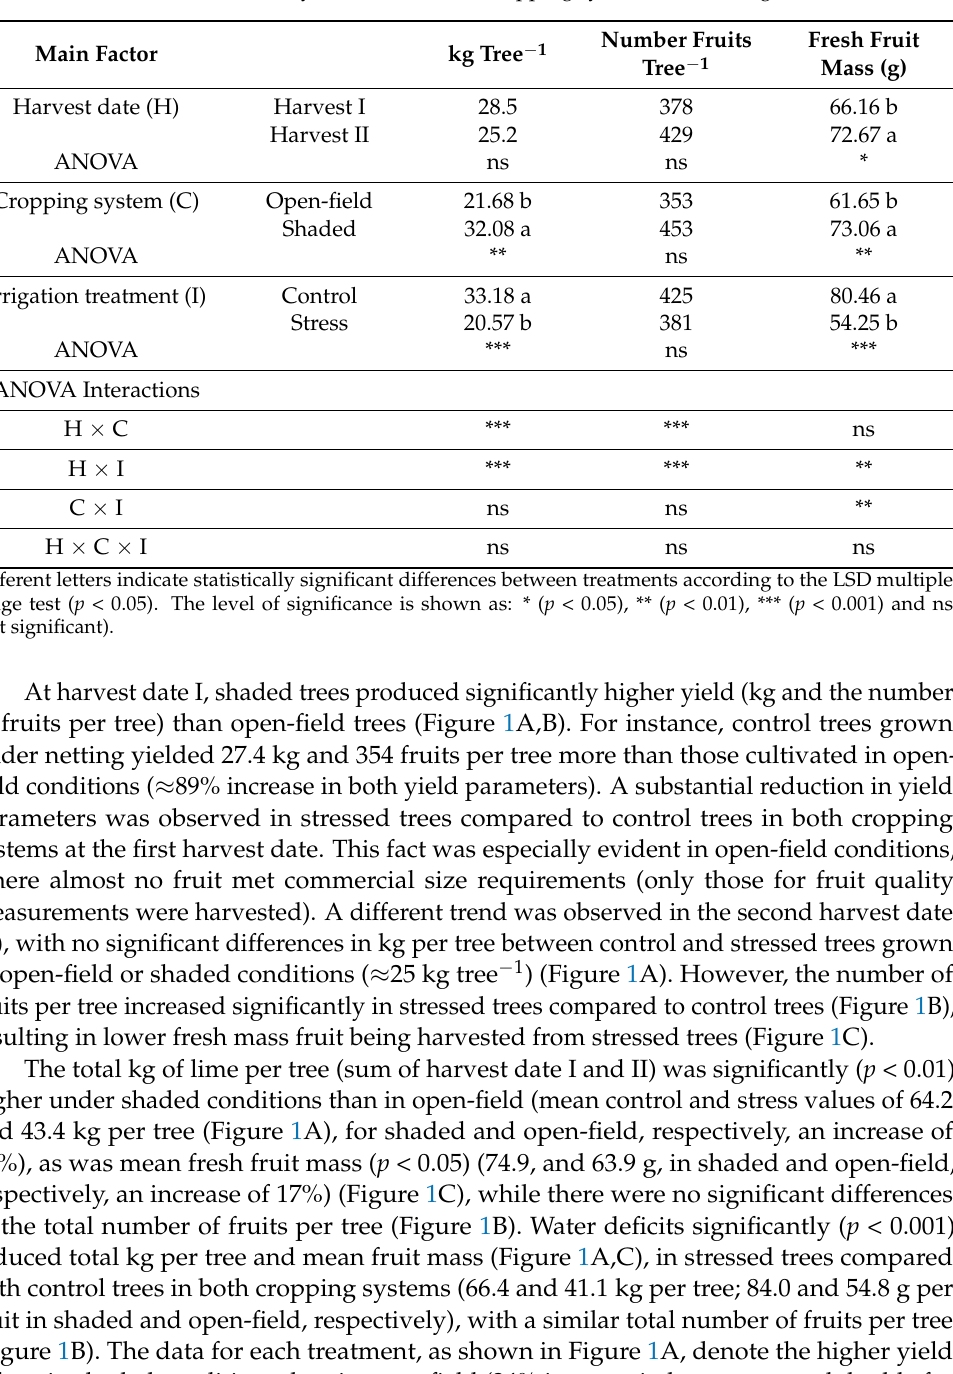
Table 3. Analysis of variance (ANOVA) of lime yield parameters (kg and number of fruits per tree and fresh fruit mass), as affected by harvest date (H), cropping system (C) and irrigation treatment (I). Main Factor kg Tree − 1 Harvest date (H) Harvest I ANOVA